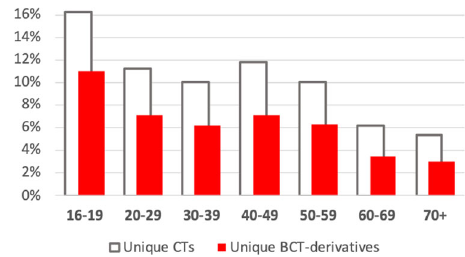
Fig. 3 Percentage of occurrences of color-term word types. White bars represent occurrence of word types in color vocabulary of participants of different age groups in general; red bars indicate occurrence of the 12 Russian BCTs and their